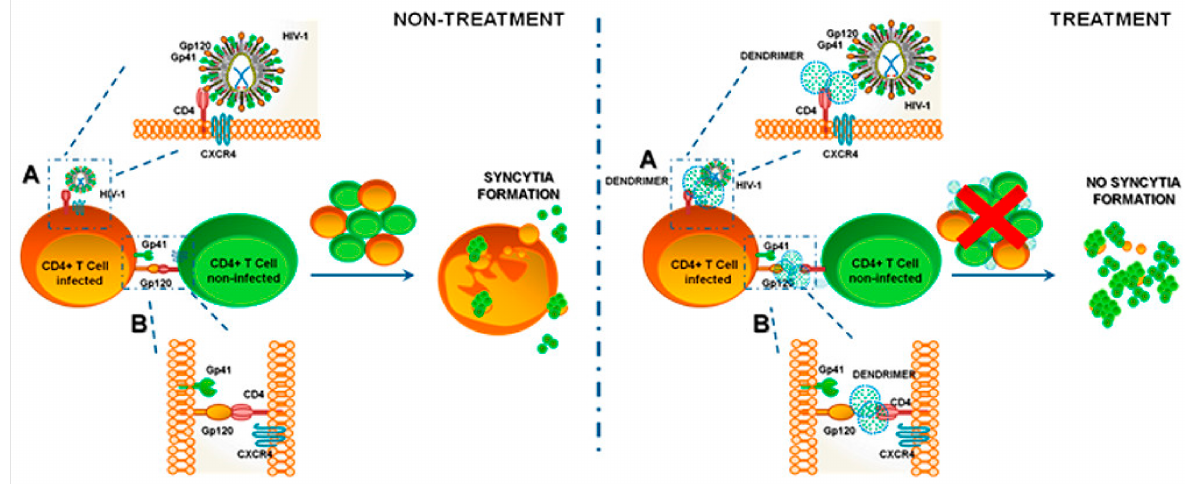
Figure 3. An example of anti-HIV activity of carbosilane dendrimers based on the gp120/CD4 receptor. Prevention of syncytia formation. Small T cell-formed syncytia can transfer virus to uninfected cells is another advantage of carbosilane dendrimers [83]. Reprinted from Guerrero-Beltran C. et al. Anionic Carbosilane Dendrimers Destabilize the GP120-CD4 Complex Blocking HIV-1 Entry and Cell to Cell Fusion. Bioconjug. Chem. 2018. Copyright © 2018, American Chemical